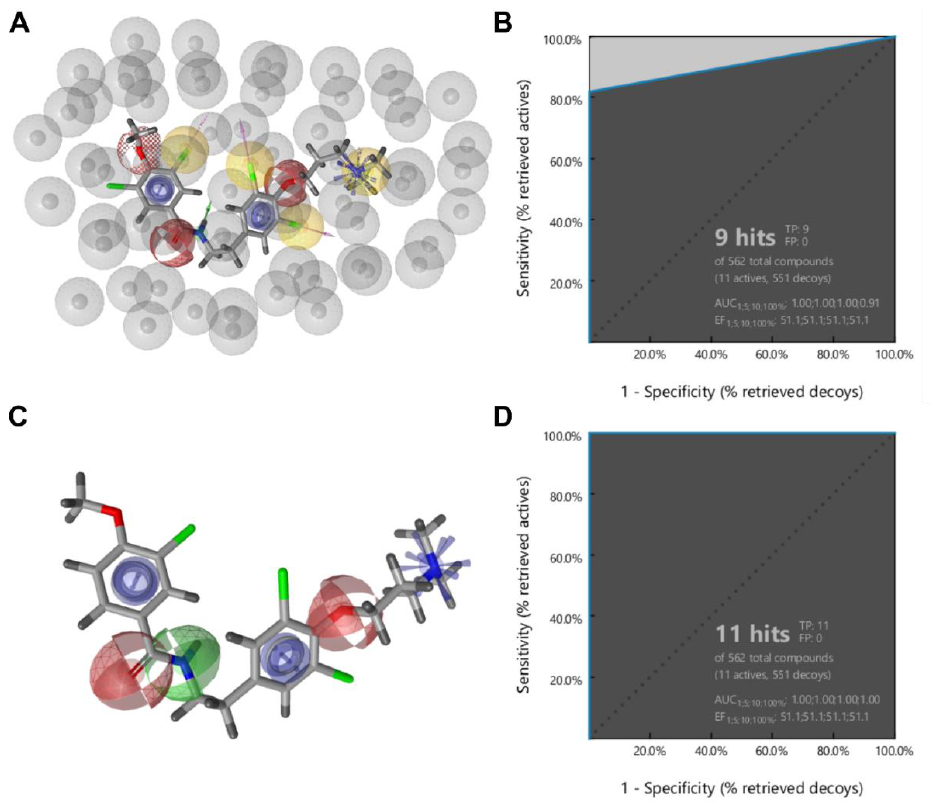
Figure 7. ( A ) Initial ligand-based pharmacophore model for K V 10.1 inhibitors based on a library of purpurealidin analogues. Common chemical features of the aligned molecules include 4 hydrophobic features (yellow spheres), 3 hydrogen bond acceptors (red spheres), 1 hydrogen bond donor (a green arrow), 2 aromatic features (blue discs), 1 positive ionisable feature (blue star), 3 halogen bond features (pink arrows), and exclusion volumes (grey spheres) that define restricted regions based on the shape of the aligned molecules. Optional features are marked as dashed. ( C ) Final ligand-based pharmacophore model. Common chemical features of the aligned molecules include 2 hydrogen bond acceptors (red spheres), 1 hydrogen bond donor (a green sphere), 2 aromatic features (blue discs), and 1 positive ionisable feature (blue star). Grey spheres for exclusion volumes are not shown. Resulting ROC plot (curve shown in blue) for ( B ) initial and ( D ) final LBPM from virtually screening 562 compounds (11 K V 10.1 active compounds and 551 generated decoys) with the ligand-based pharmacophore model. TP = true positives; FP = false positives; AUC = area under the curve; EF = enrichment factor.